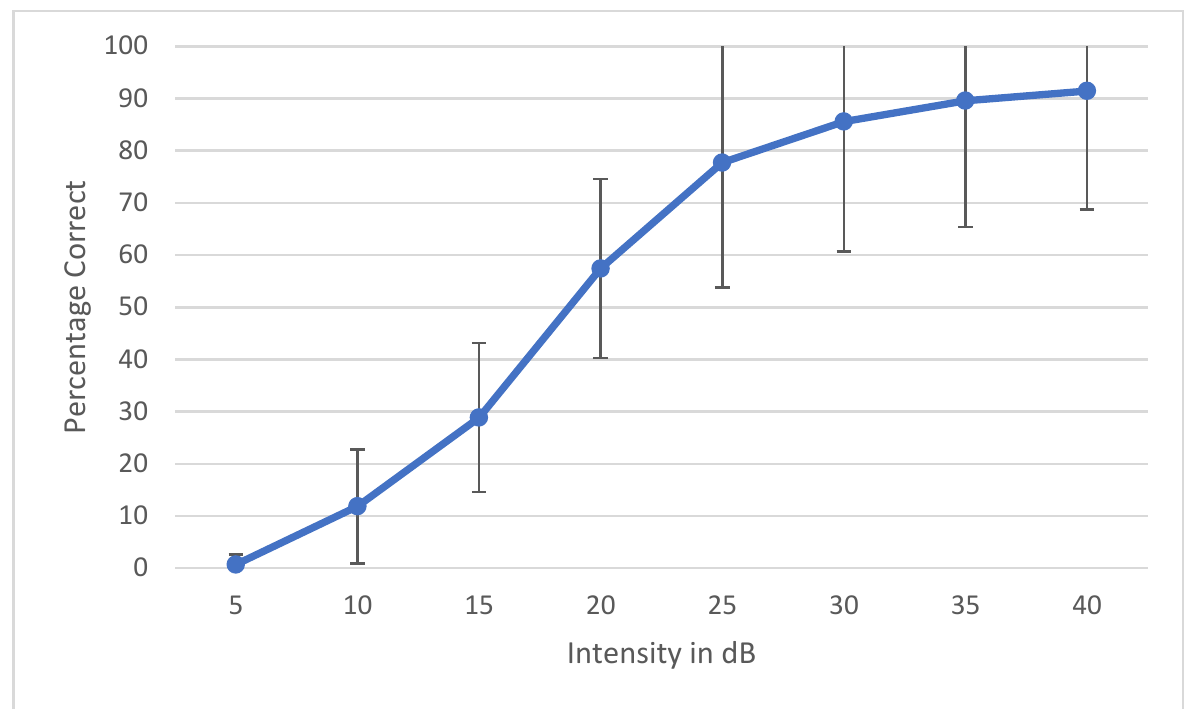
Figure 2. Psychometric properties for the Maltese AAST words in adults in quiet.